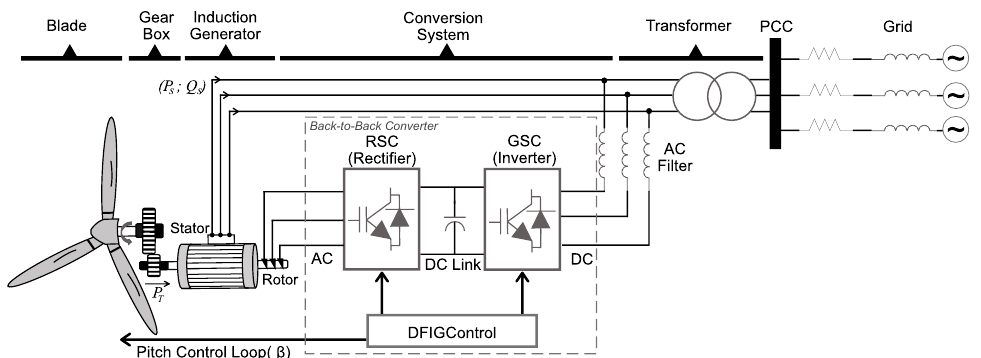
Figure 1. Simplified DFIG diagram.